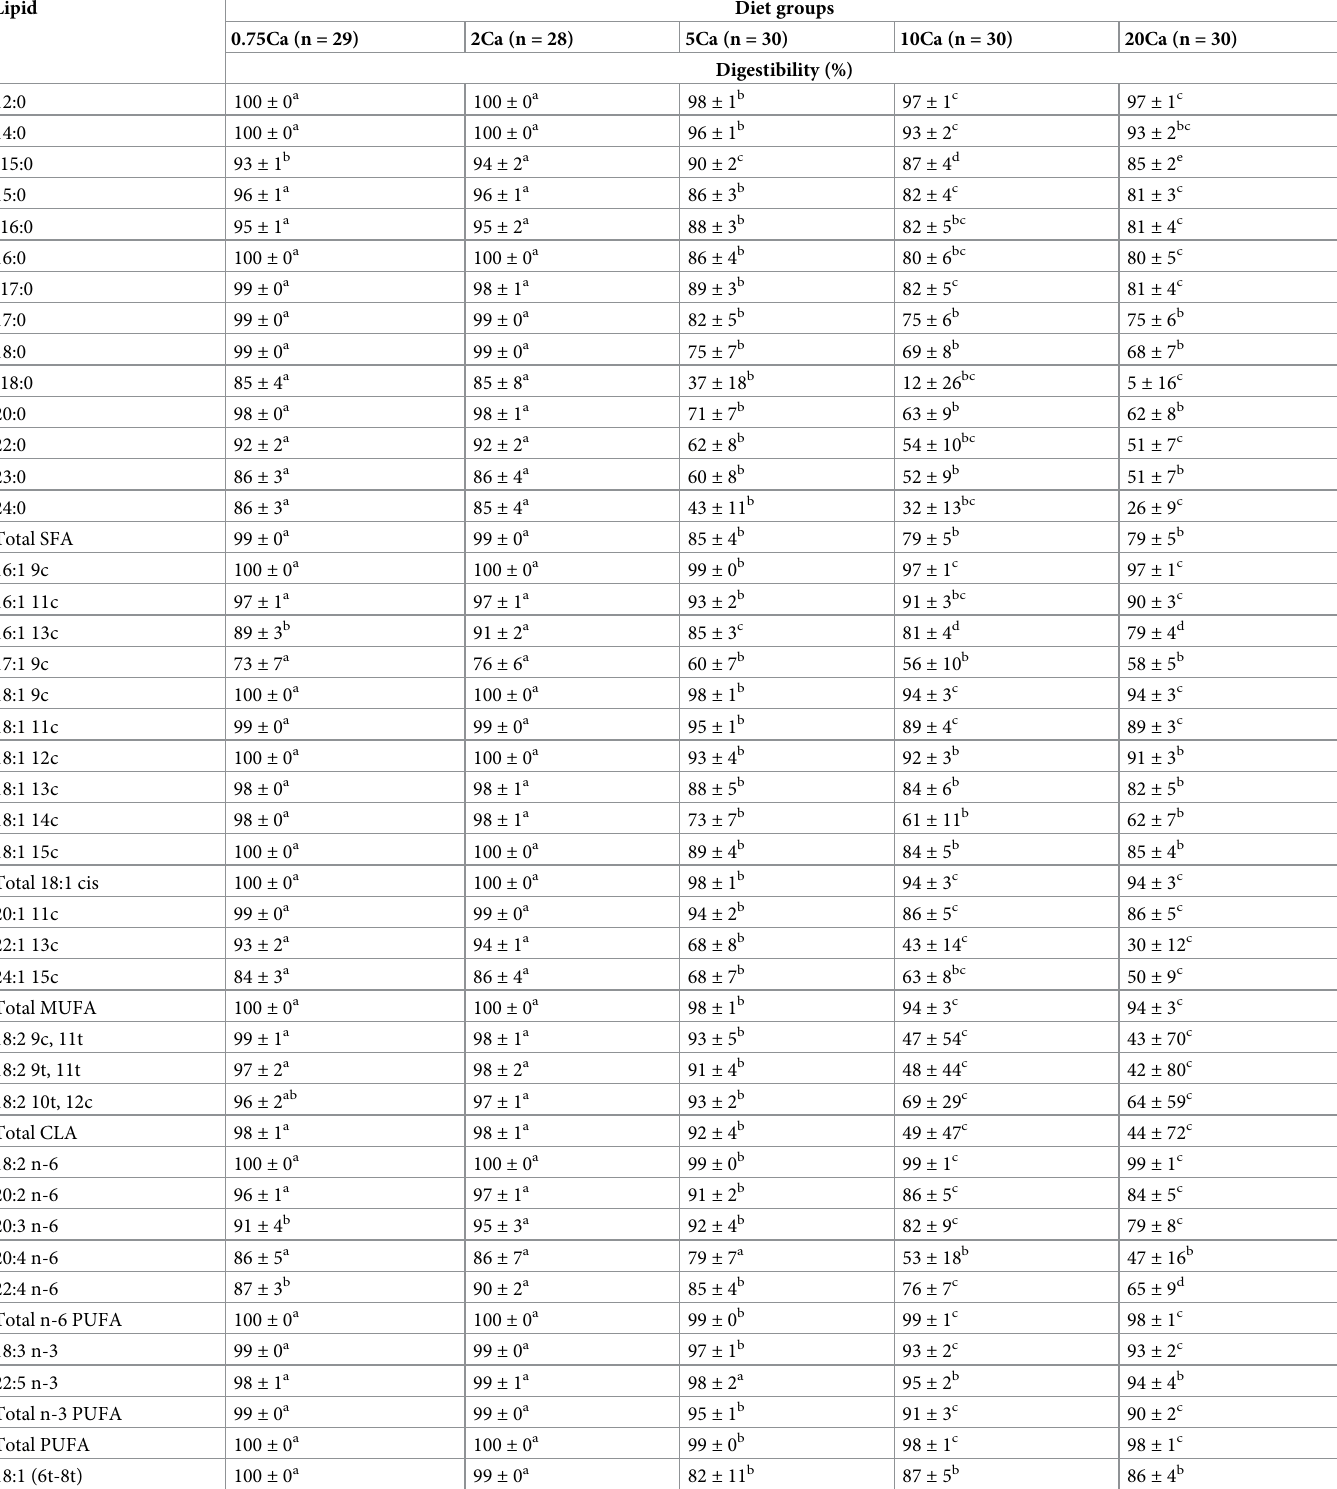
Table 4. Apparent total lipid and fatty acid digestibility during week 3 of the study. Lipid Diet